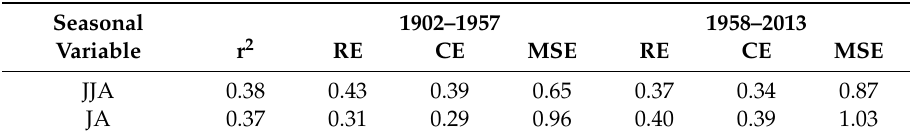
Table 6. Measurement of the prediction skill of the linear model for two combinations of seasonal variables for temperature reconstructions and for two periods, 1902–1957 (verification) and 1958–2013 (calibration), using the stable carbon isotope ratio in tree rings: squared correlation coe ffi cient for the entire period of available climate data (r 2 ), reduction of error (RE), coe ffi cient of e ffi ciency (CE), mean squared error